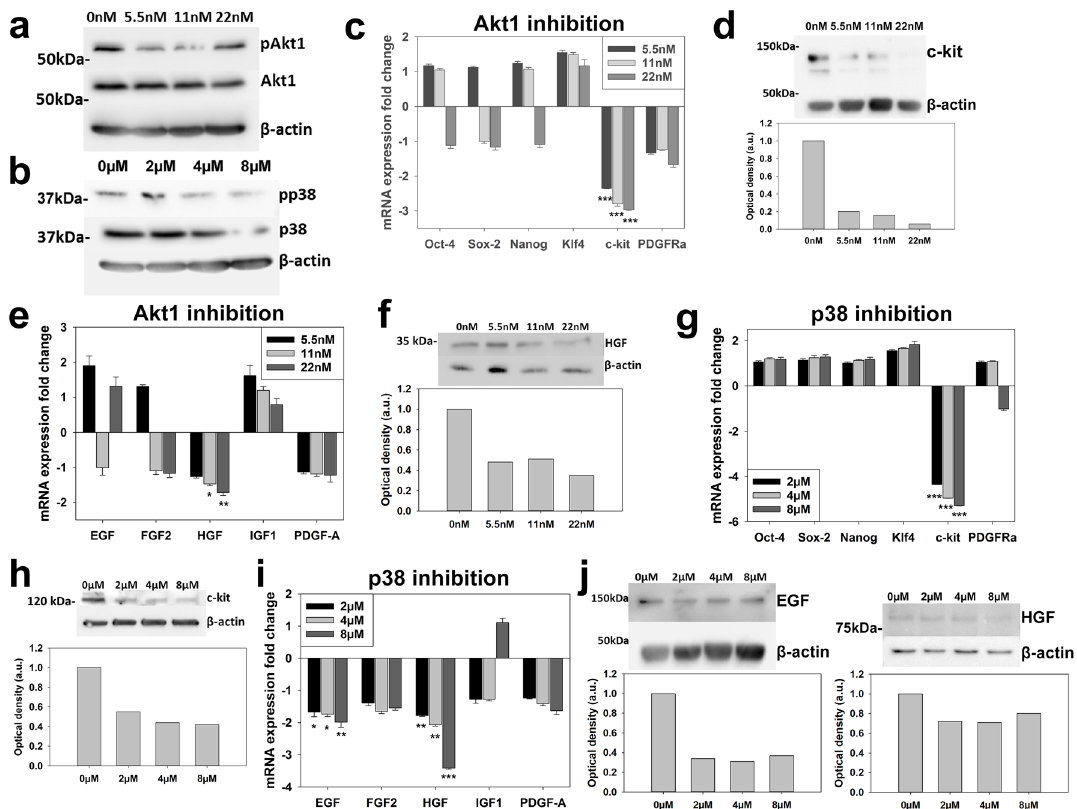
Figure 5. Specific second messenger blockade impacts on CPC characteristics. Application to CPCs of ( a ) Akt1 blocker A674563 or ( b ) p38 inhibitor SB203580 caused down-regulation of respective signalling pathways. ( c ) A674563 downregulated c-kit gene activity but did not impact on CPC ‘stemness’ genes or PDGFRα expression (n = 3), with ( d ) c-kit protein expression also assessed. ( e ) A674563 reduced expression of HGF mRNA (n = 3), with ( f ) protein expression also assessed. ( g ) SB203580 downregulated c-kit gene activity but did not impact on CPC ‘stemness’ genes or PDGFRα expression (n = 3), with ( h ) c-kit protein expression also assessed. ( i ) SB203580 significantly reduced EGF and HGF mRNA expression, with ( j ) protein expression also assessed. All data are mean ± SEM; significance was determined by ANOVA with Holm-Šídák post hoc test to identify differences (* p < 0.05; ** p < 0.01; *** p < 0.001). Blots cropped to relevant data, with optical density normalized to the loading control protein; full blot images presented in Supplementary Fig.